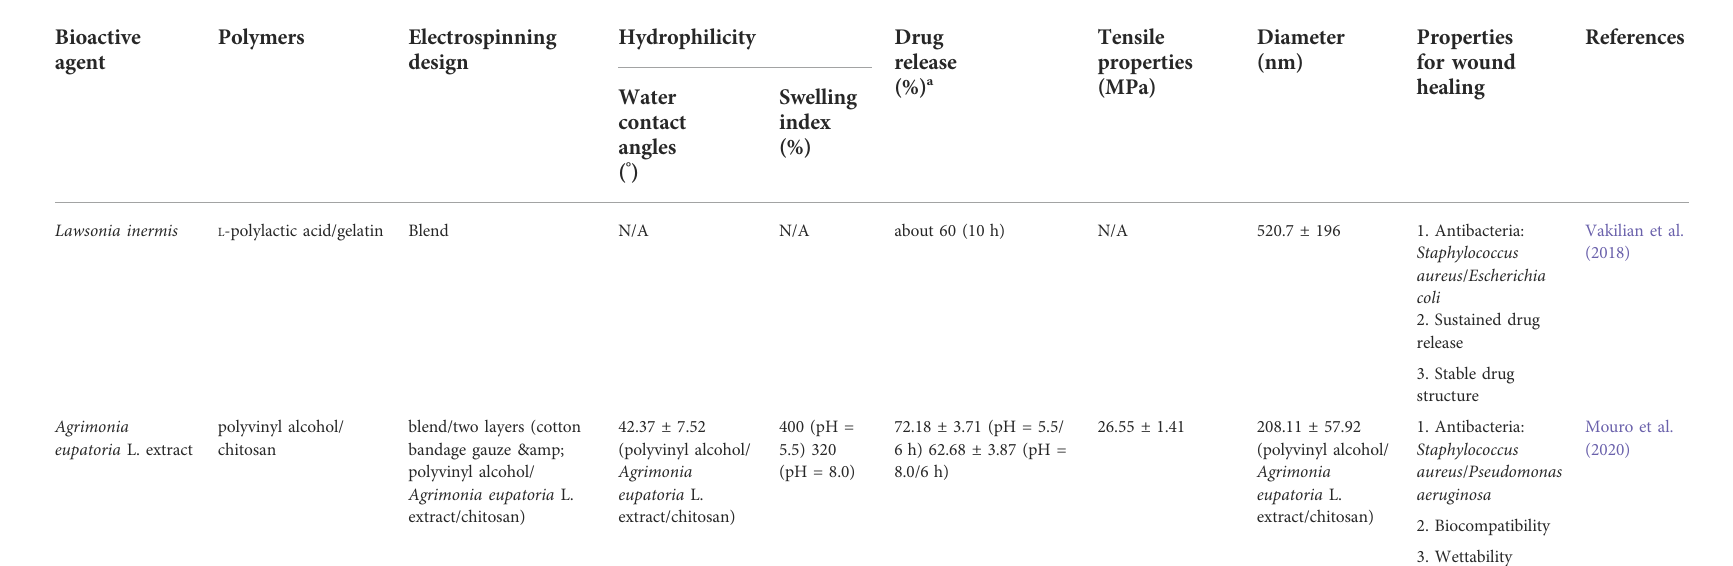
TABLE 1 ( Continued ) Botanicals as loaded-drugs used in electrospinning for wound